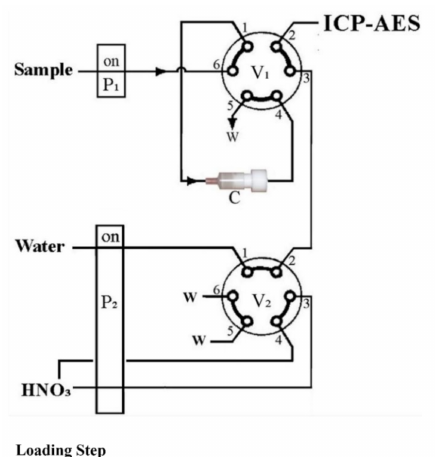
Figure 3. Schematic diagram of the on-line column preconcentration manifold for multi-element analysis by ICP-AES. P 1 , P 2 —peristaltic pumps; V 1 , V 2 —injection valves, V 1 in “load” position; V 2 in “A” position; W—waste; C—microcolumn packed with sol-gel thiocyanatopropyl silica sorbent. A METROHM 654 pH-meter (Metrohm AG, Herisau, Switzerland) was employed